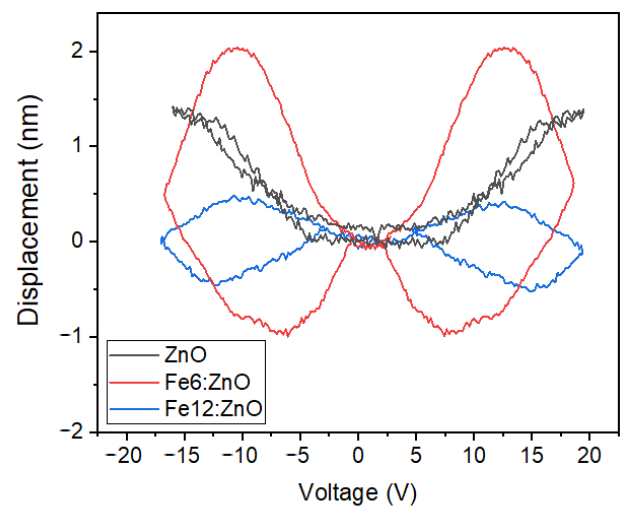
Figure 10. Electromechanical displacement vs. applied bias voltage, measured for ZnO and Fe:ZnO NPs with different doping levels.